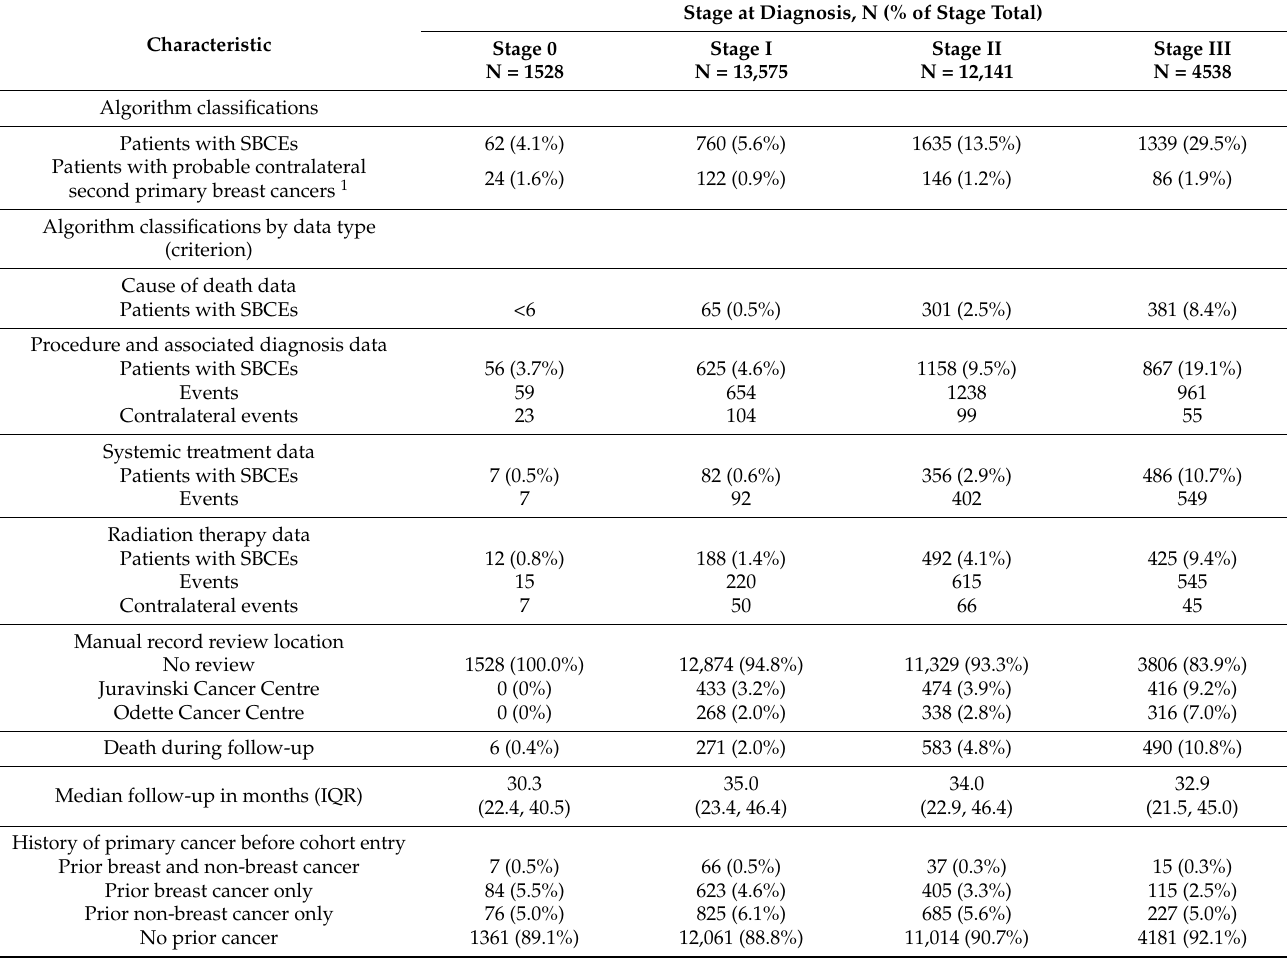
Table 2. Algorithm classifications of second breast cancer events (SBCEs) in the entire cohort.